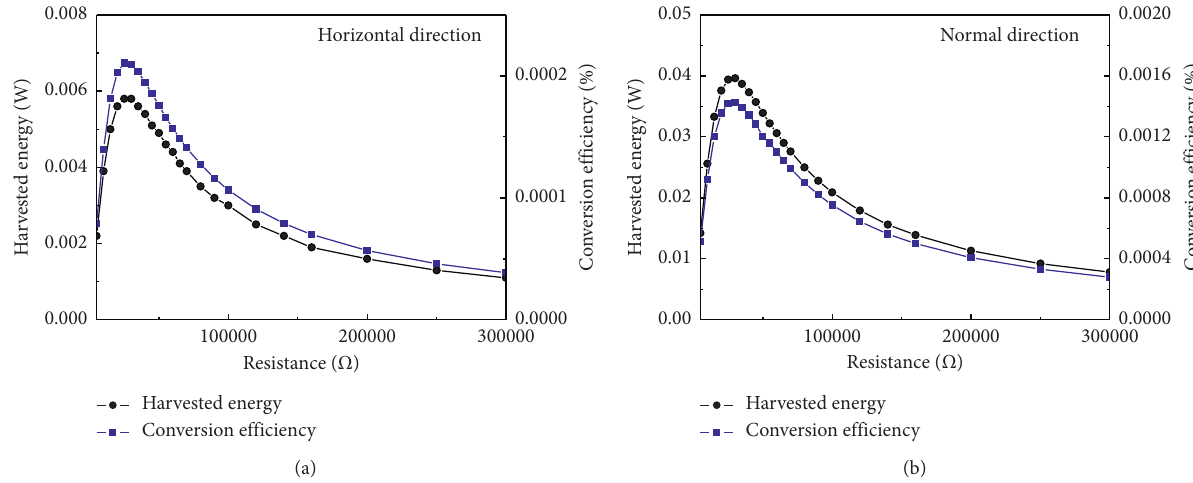
Figure 28: Considering separation, the harvested energy and conversion efficiency of the friction system in the horizontal direction (a) and normal direction (b) with different external electrical